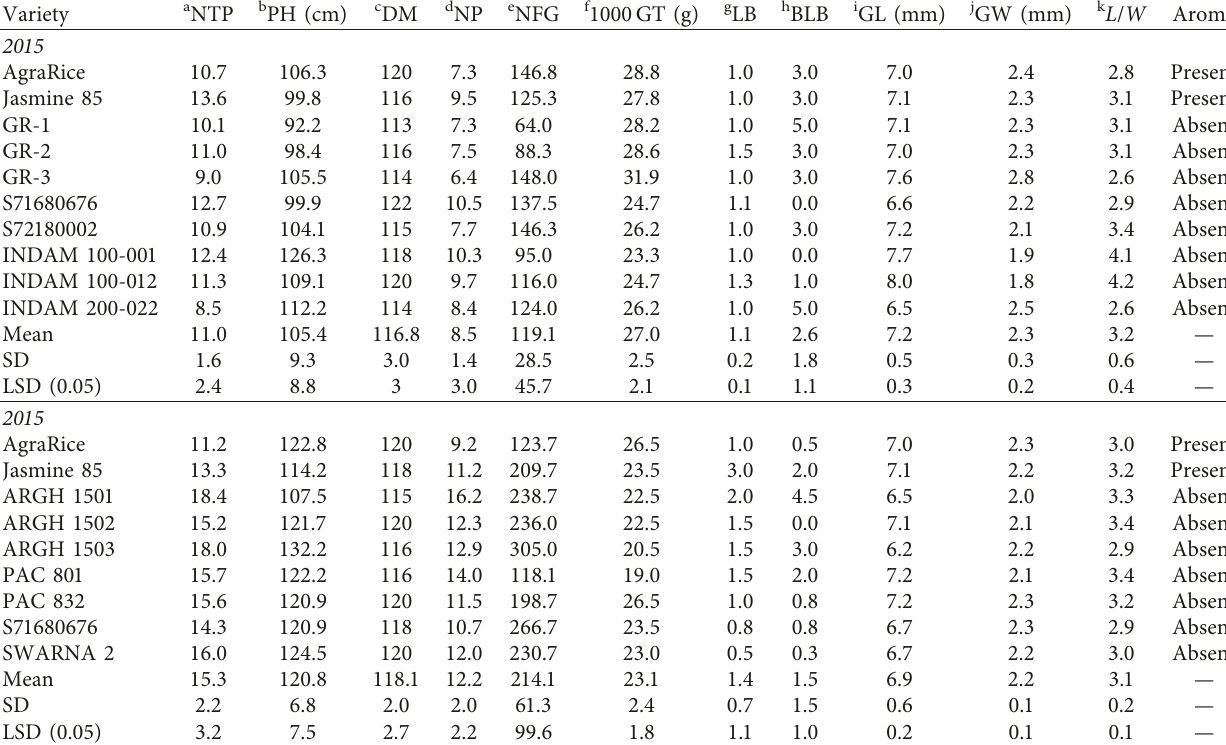
Table 7: Yield components, reaction to diseases, and grain quality attributes of hybrids and checks in 2014 and 2015.